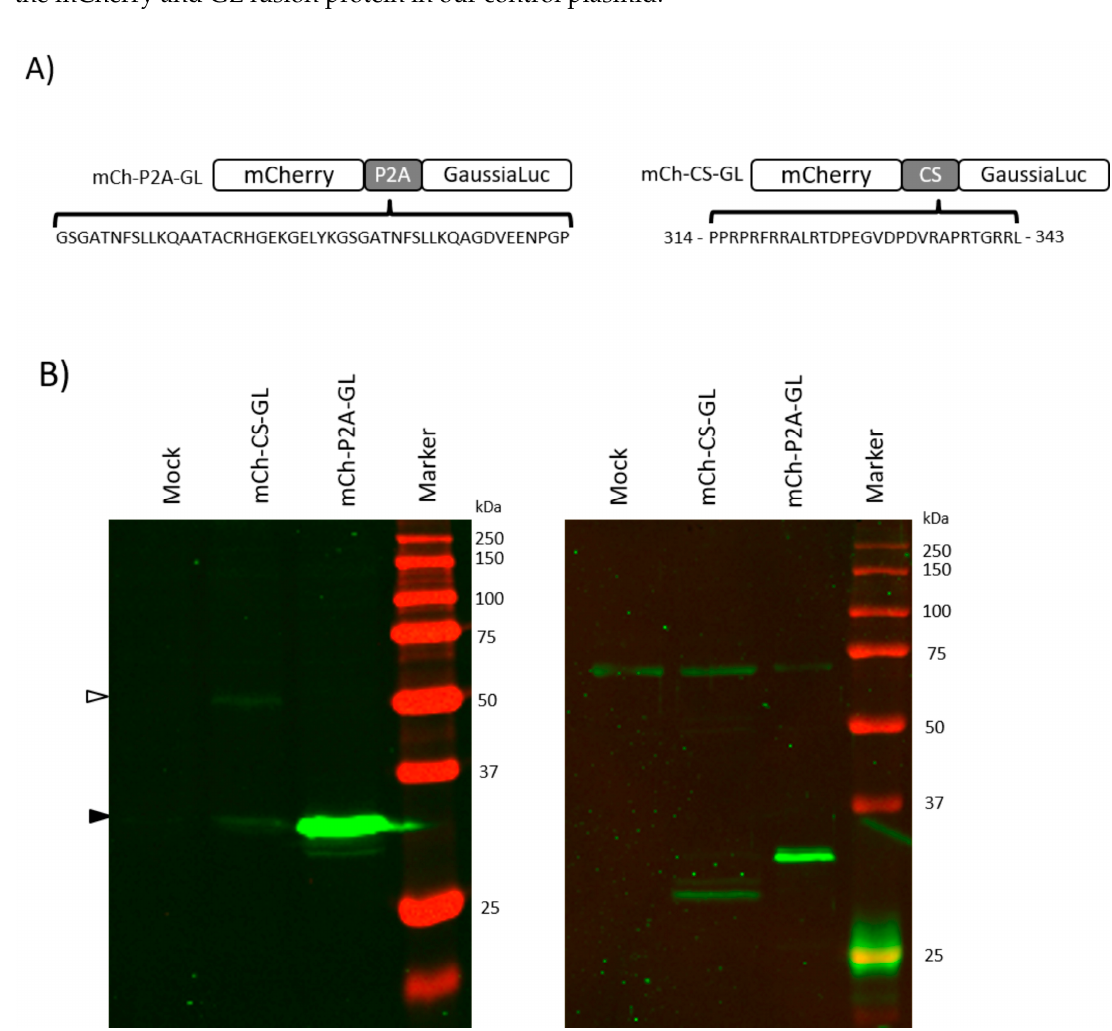
Figure 3. Cloning of the CS sequence into reporter constructs transfers cleavage activity. ( A ) Schematic representation of constructs expressing mCherry and Gaussia luciferase (GL) separated by the P2A or CS sequences. The amino acid sequences of the P2A and CS are shown. ( B ) Western blots showing detection of mCherry (anti-RFP antibody [5F8], shown in green) in cell lysate (left blot) and supernatant (right blot) of HEK-293T cells transfected with mCh–CS–GL and mCh-P2A-GL. Black arrowhead indicates position of cleavage product, white arrowhead indicates precursor protein. One of three independent experiments is